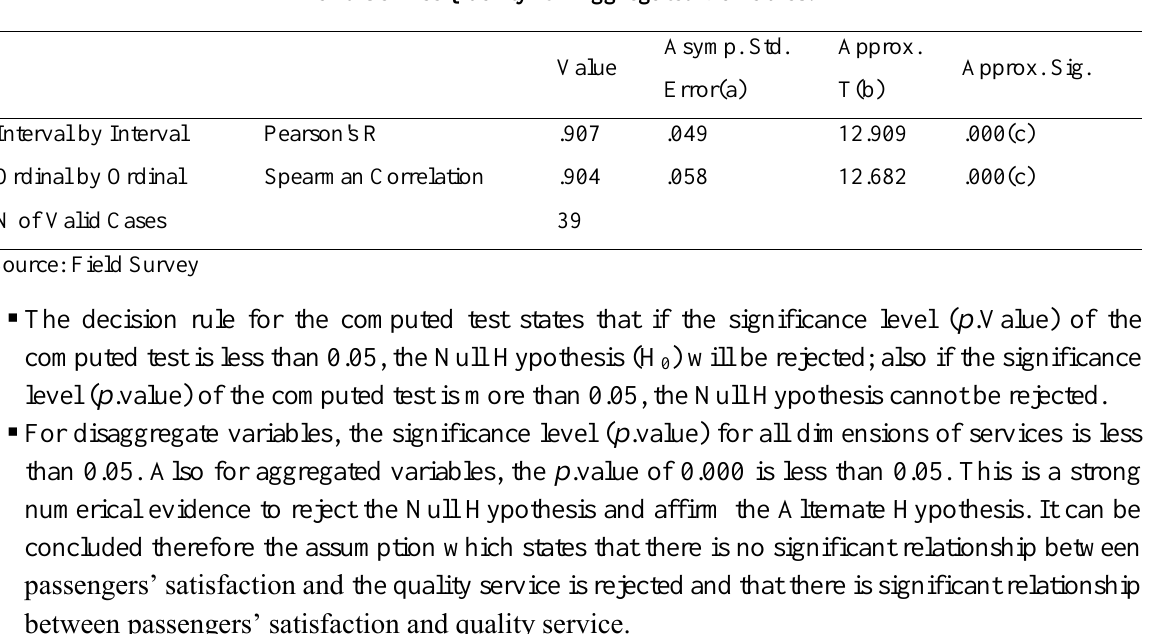
Table 7. Charles Spearman’s Rank Correlation Showing the Relationship between Passenger’s Satisfaction and Service Quality for Aggregated